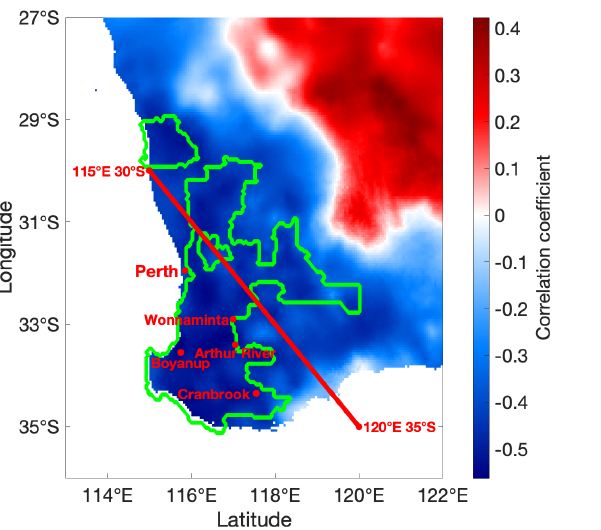
Figure 1. The correlation map for the southwestern part of the WA region for a 6-year window for AWAP rainfall and DSS snow ac- cumulation from 1900 to 2015CE. The outlined area (green line) is the MASK region where the correlation is statistically signifi- cant ( p < 0.05). The red diagonal line connecting 30 ◦ S, 115 ◦ E and 35 ◦ S, 120 ◦ E is the boundary of SWWA (van Ommen and Mor- gan, 2010). Perth is the capital city of WA. Boyanup, Wonnaminta, Arthur River and Cranbrook are the four significant (6-year window, p < 0.05) stations.